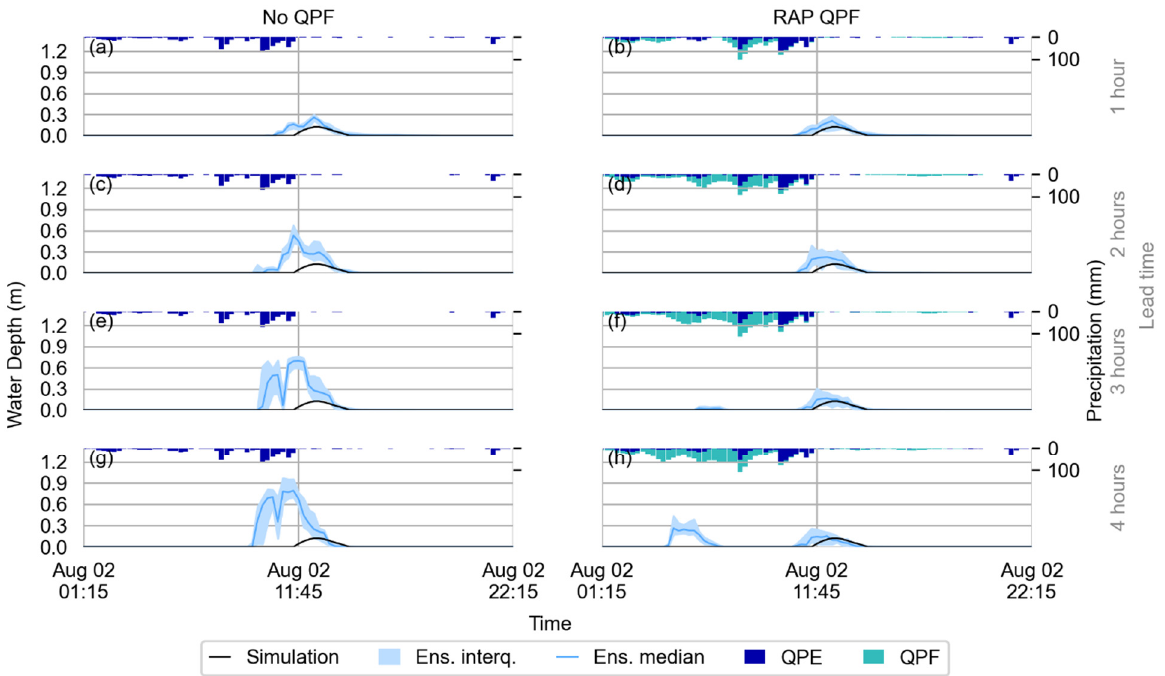
Figure 15. ( a – h ) Same as Figure 14, but for POI 2.